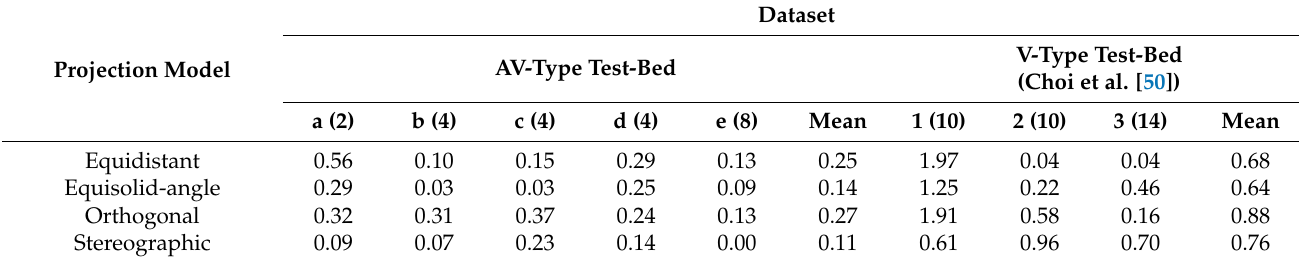
Table 16. Comparison of absolute error of focal length (pixel).